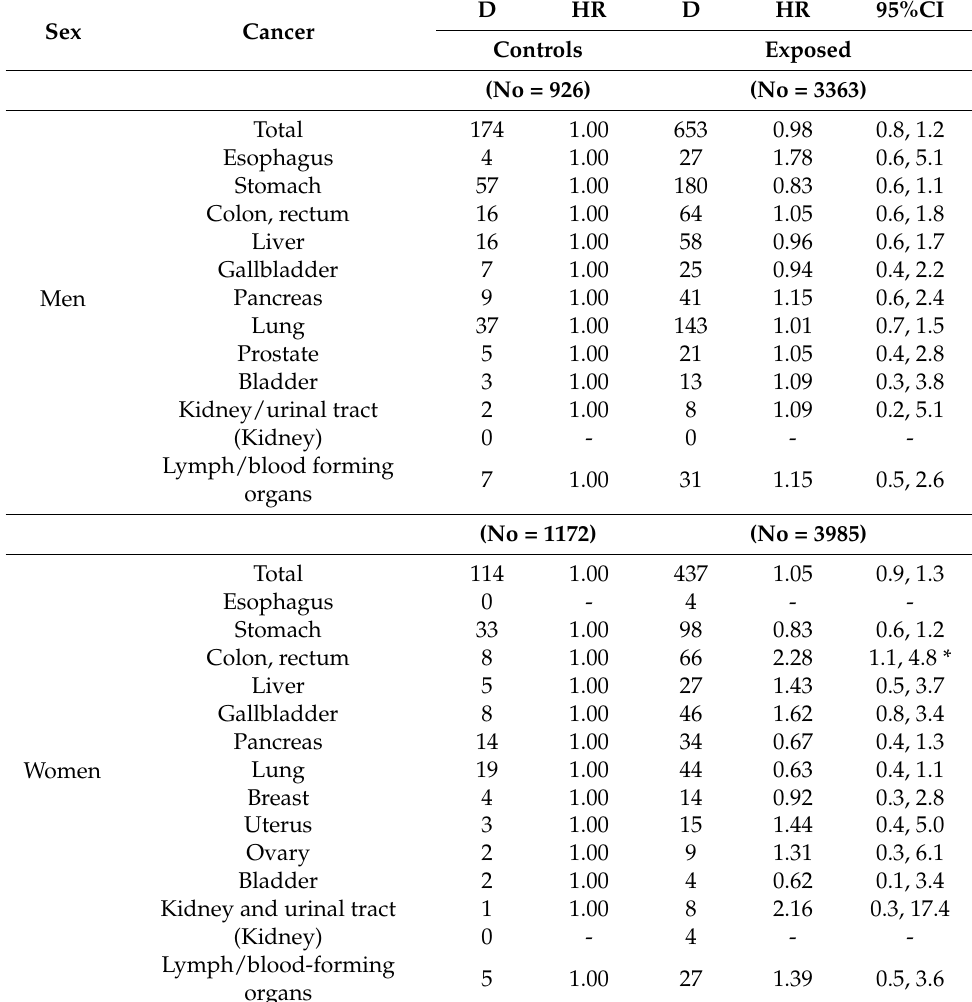
Table 4. Mortality risk ratios for malignant neoplasms of Cd-exposed subjects compared with controls. Sex Cancer